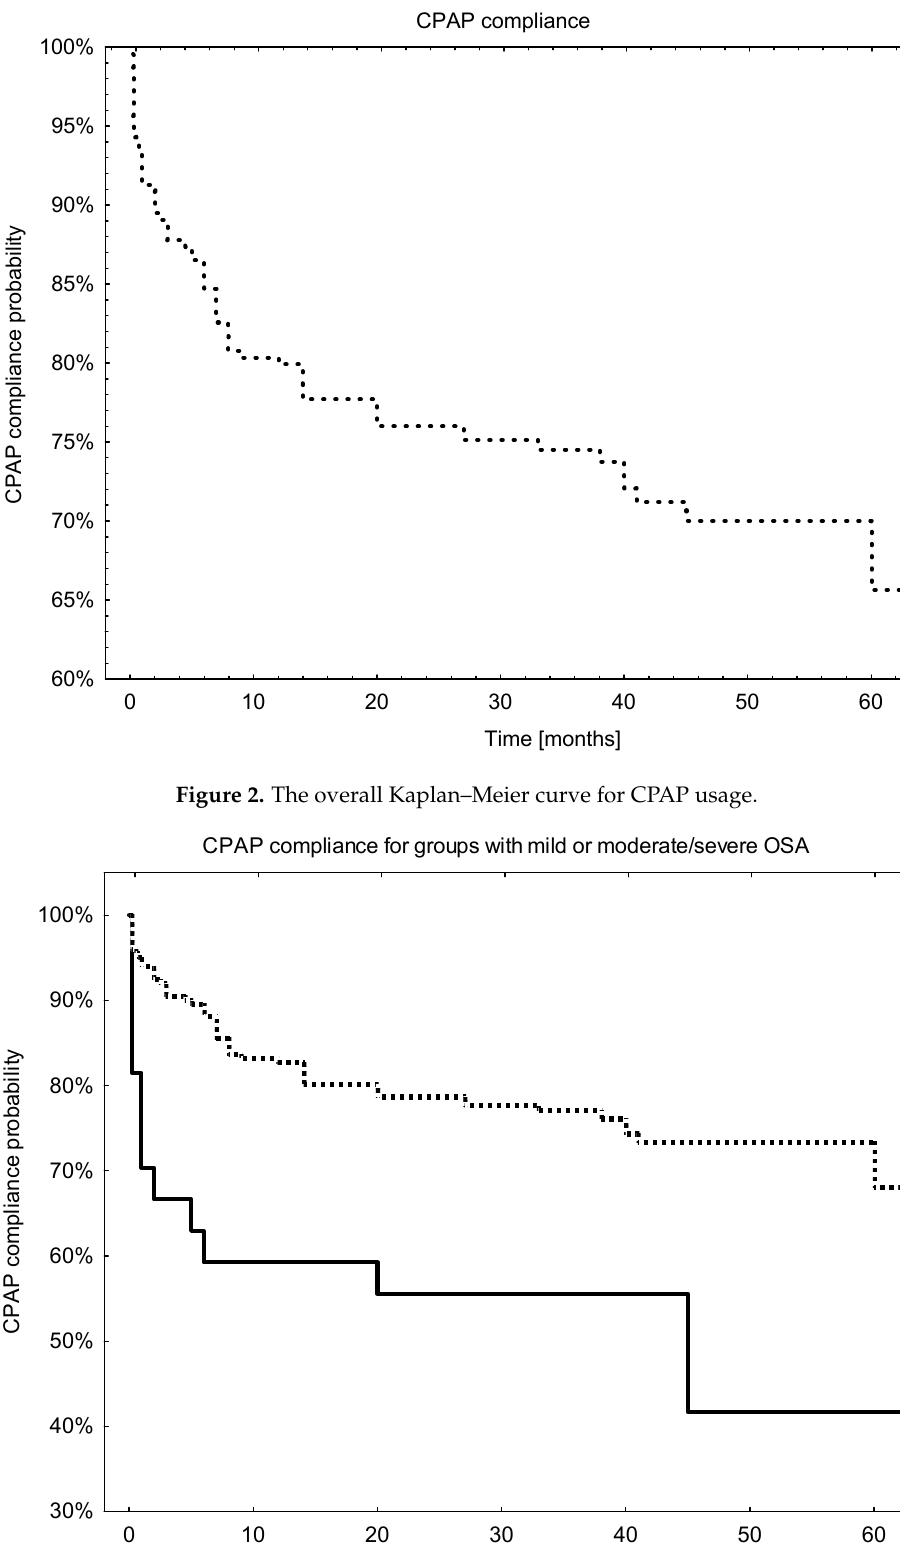
Table 5. Proportional regression of Cox’s hazard.